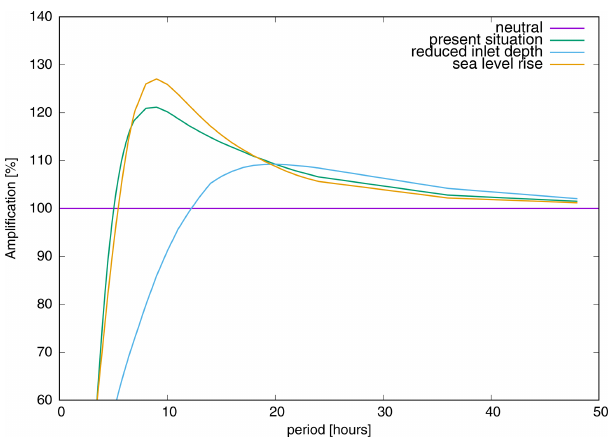
Figure 3. Amplification (percentage, y axis) of sea level oscillations in the Venice city centre with respect to their amplitude at the lagoon inlets as a function of their period (hours, x axis). The curves show the present situation (green), a hypothetical reduction to 6m of the depth of the three inlets of the lagoon (light blue), and an RSL rise of 1m without any change in the morphology of the lagoon (yellow). Values higher (lower) than 100 (shown for reference) correspond to amplification